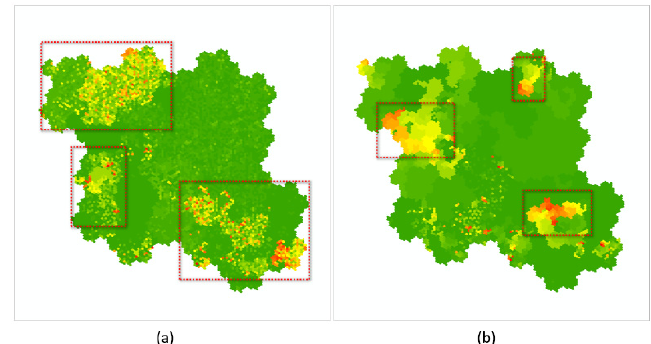
Figure 14. The comparison of the file base map before and after clustering: ( a ) data that have not been clustered; ( b ) data that have been clustered.